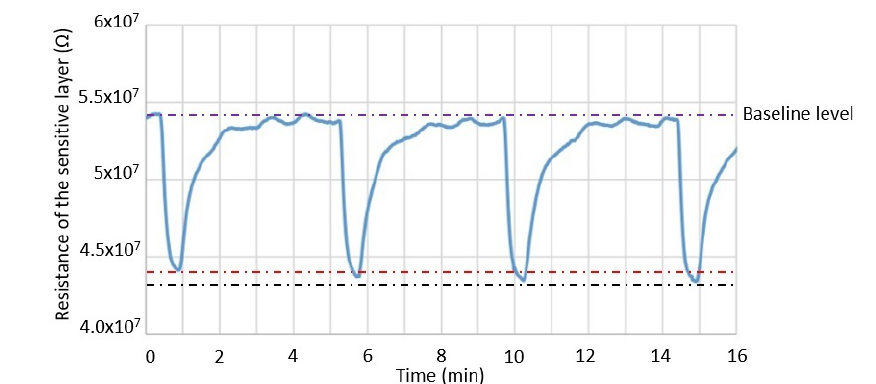
Figure 9. Response reproducibility of the composite heater towards 100 ppb of ethanol while the sensor is operating at 10.5 mW. The red and black lines represent the lowest and highest resistivity observed during exposure to 0.1 ppm of ethanol,